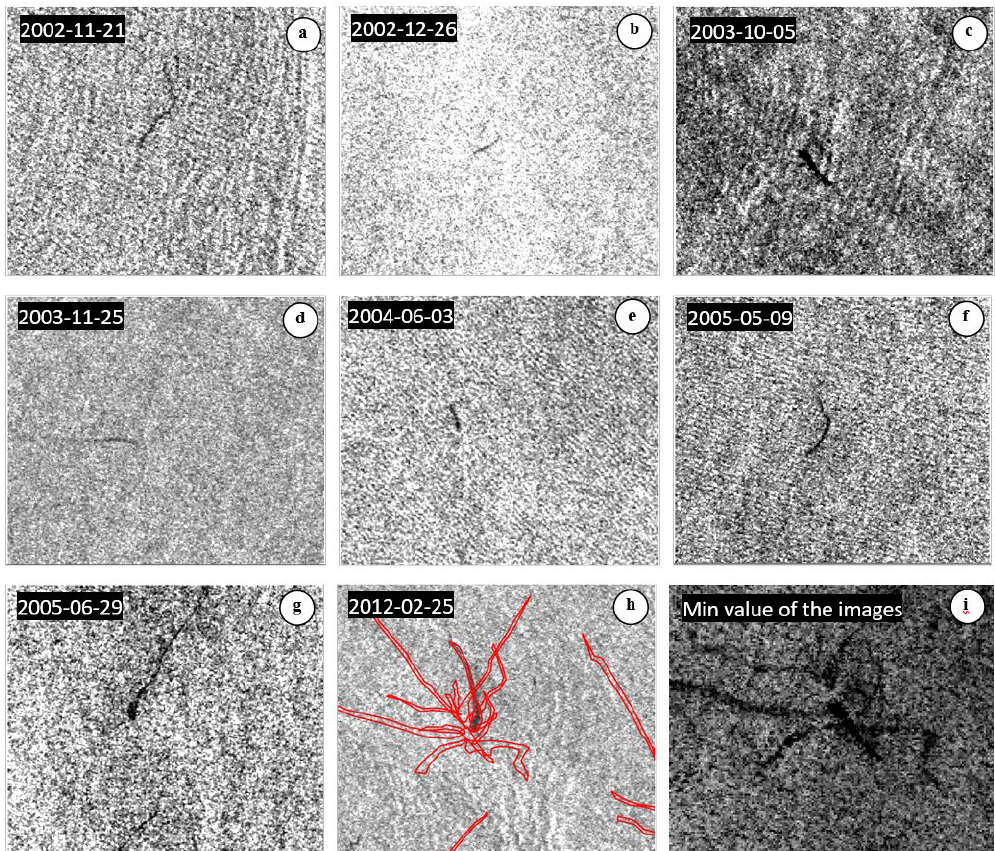
Figure 10. An example of a multitemporal analysis with an “astroseep” (flower-like) structure observed in the Lower Congo basin. Im- ages (a) , (b) , (c) , (d) , (e) , (f) , and (g) are Envisat ASAR images acquired on different dates with observed seeps. Image (h) shows an Envisat ASAR image with interpreted seeps. Image (i) shows the Envisat ASAR minimum image (i.e. each pixel is the minimum observed for the seven dates) with an astroseep